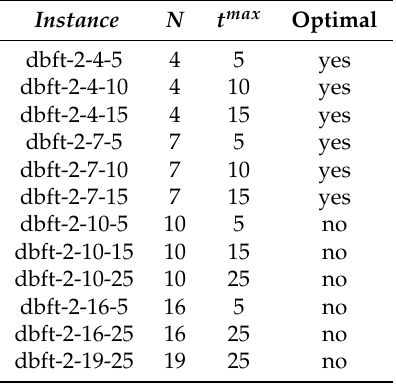
Table 3. Optimality of each instance according to time limit of 600 s, for all Scenarios P1–P7. Instance N t